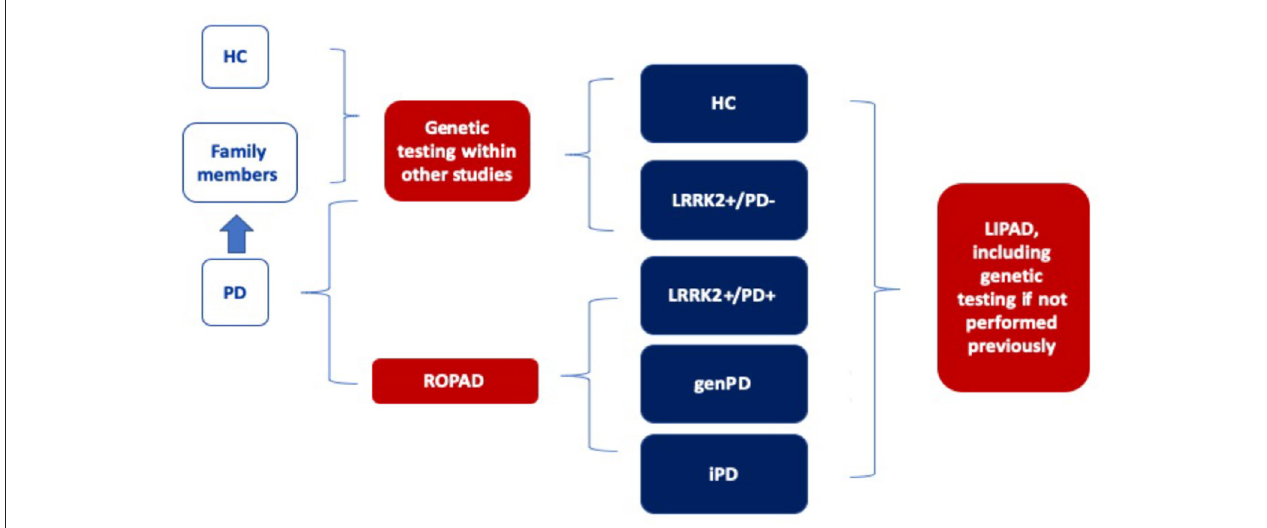
FIGURE 1 | Paths of enrolment into the LIPAD study. LRRK2 + /PD + : PD patients carrying a pathogenic LRRK2 variant, LRRK2 + /PD-: unaffected carriers of pathogenic LRRK2 variants, genPD: PD patients with pathogenic variants in PD genes other than LRRK2, iPD; LRRK2-/PD + : patients with idiopathic PD from the same populations, HC: healthy persons without pathogenic